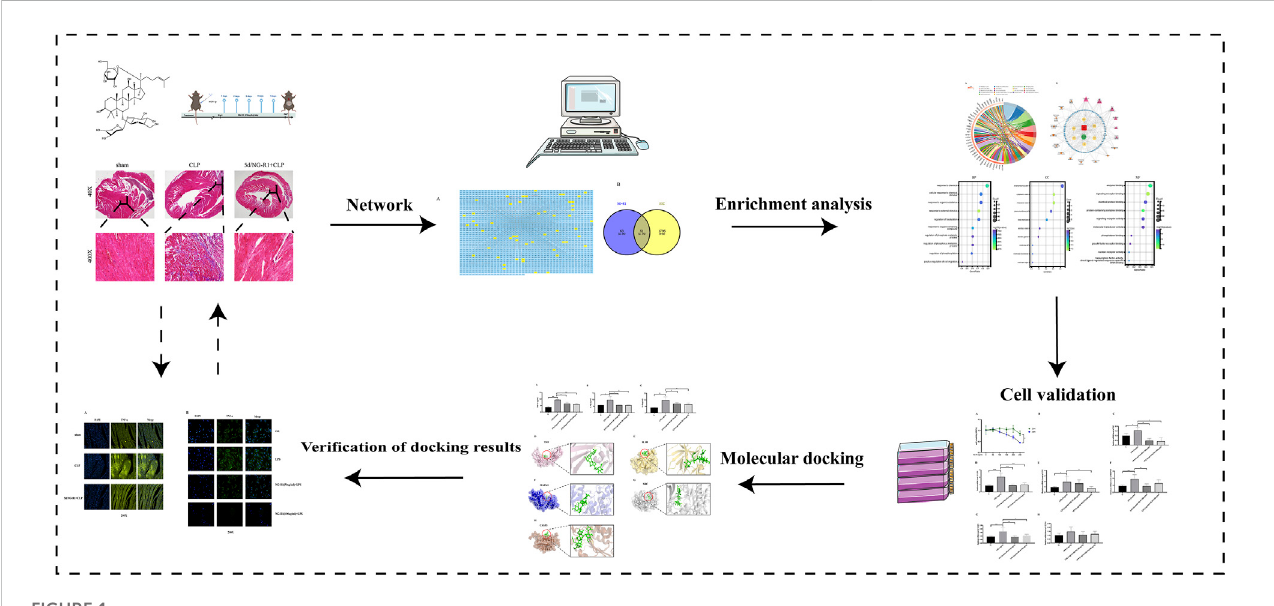
FIGURE 1 The detailed fl ow chart of the